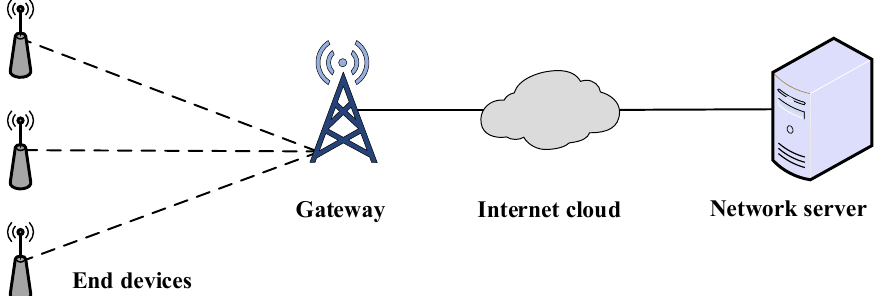
Figure 1. Star-of-Stars Topology of the LoRaWAN